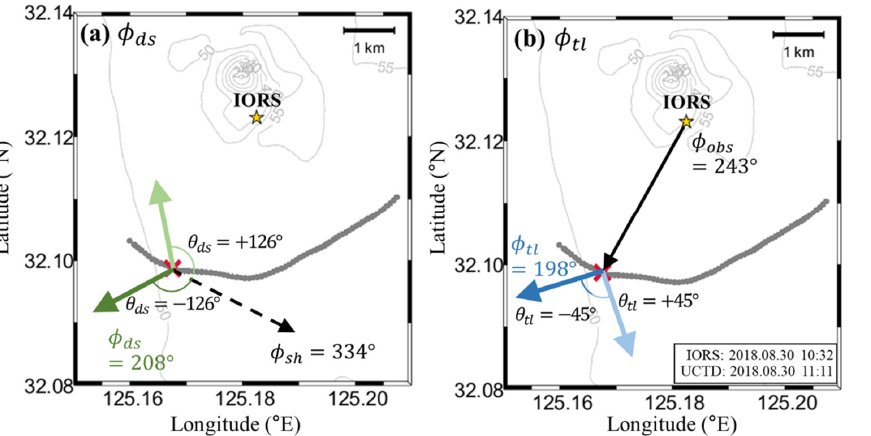
Figure 9. Propagation direction of NLIW observed during IORS18, estimated from ( a ) Doppler shift method and ( b ) time lag method. The φ sh , φ obs , θ ds , and θ tl are labeled in the plots. Dates and times of the corresponding events are noted in the right bottom corner.